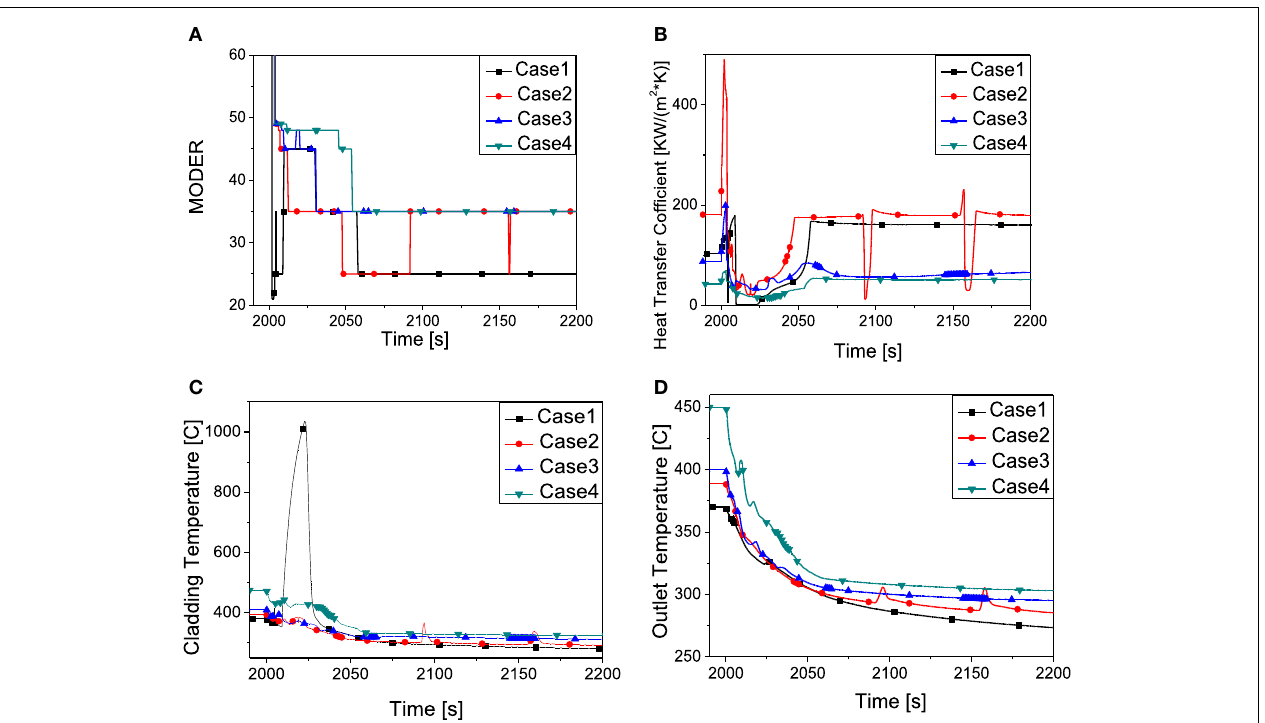
FIGURE 9 | System behavior by the effect of core outlet temperature . (A) Heat transfer mode. (B) Heat transfer coefficient. (C) Peaking cladding temperature. (D) Core outlet temperature.